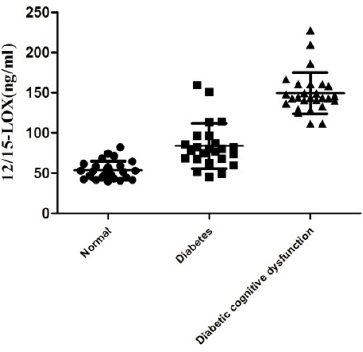
Figure 1. 12/15-LOX is related to cognitive dysfunction in diabetes patients. The level of 12/15-LOX in the plasma of the diabetic patients with cognitive dysfunction.